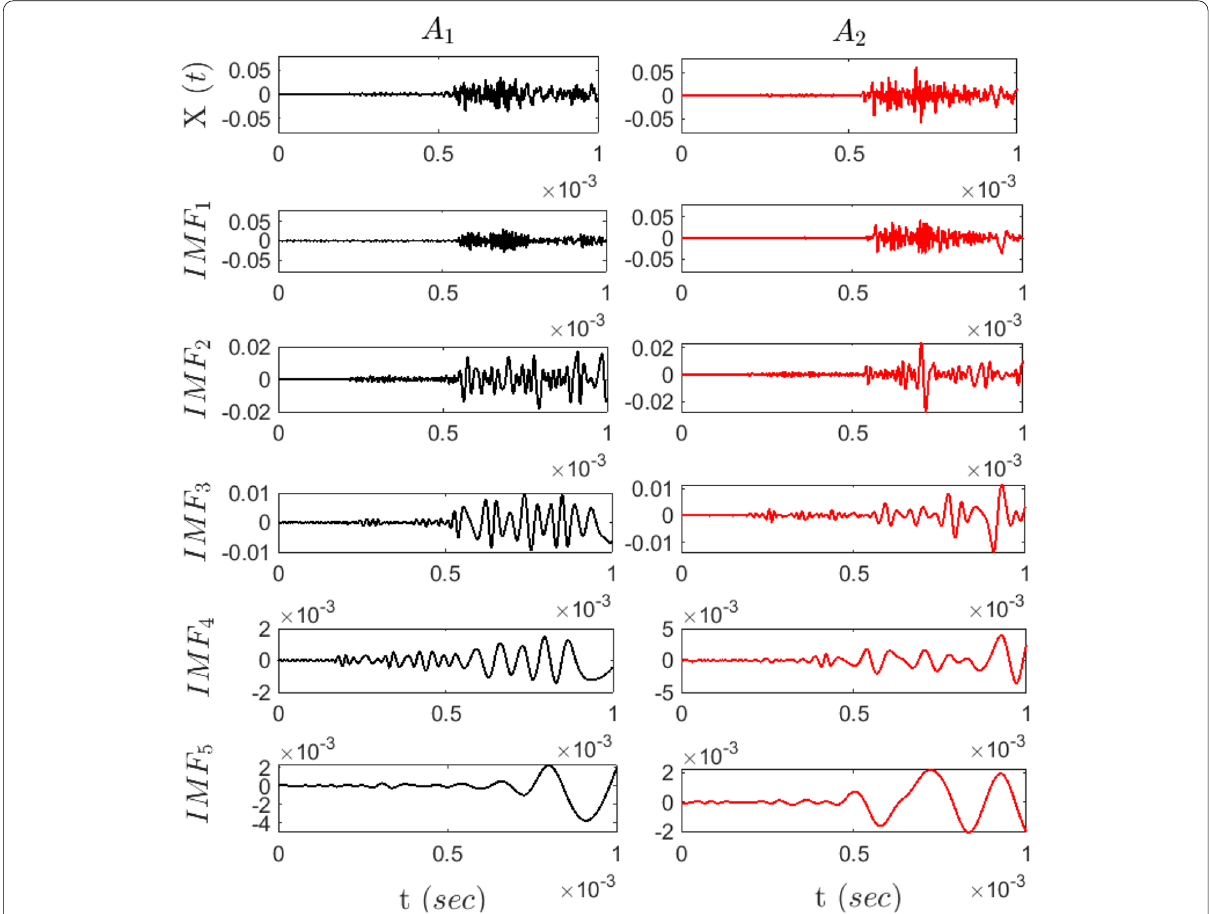
Fig. 26 Time history of the measured AE waveforms and first five IMFs extracted from sensors A1 and